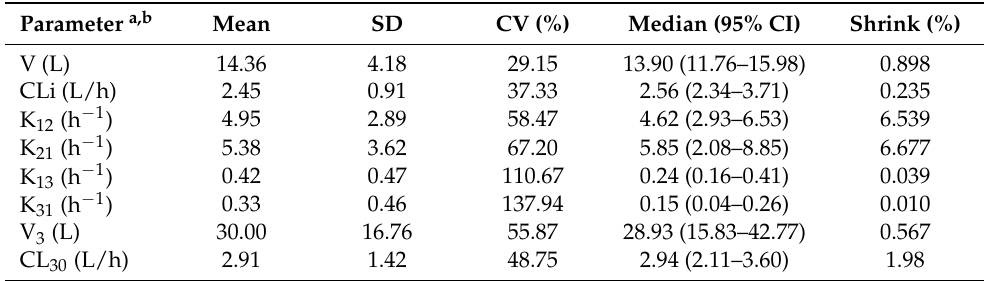
Table 4. Parameter estimates for unbound temocillin from the final covariate two-compartment Pop-PK model.